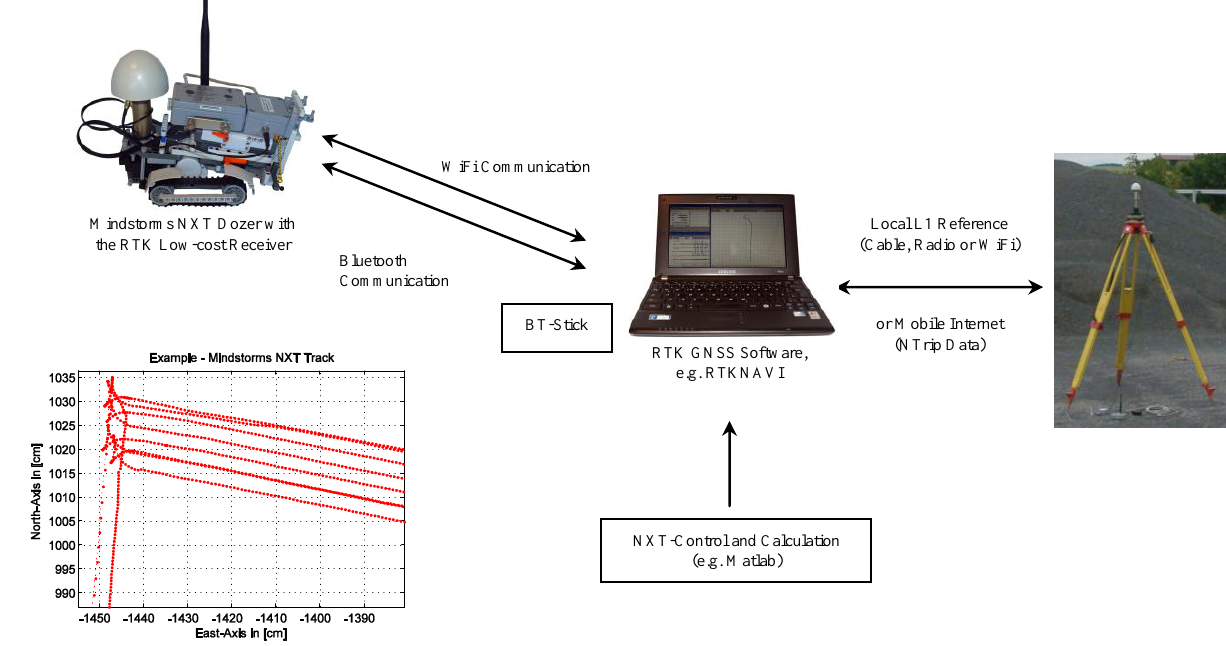
Figure 1. RTK Mindstorms NXT-Control via the RTK GNSS Low-cost